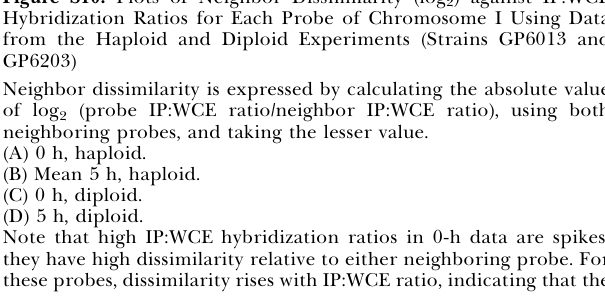
Figure S10. Plots of Neighbor Dissimilarity (log 2 ) against IP:WCE Hybridization Ratios for Each Probe of Chromosome I Using Data from the Haploid and Diploid Experiments (Strains GP6013 and GP6203)